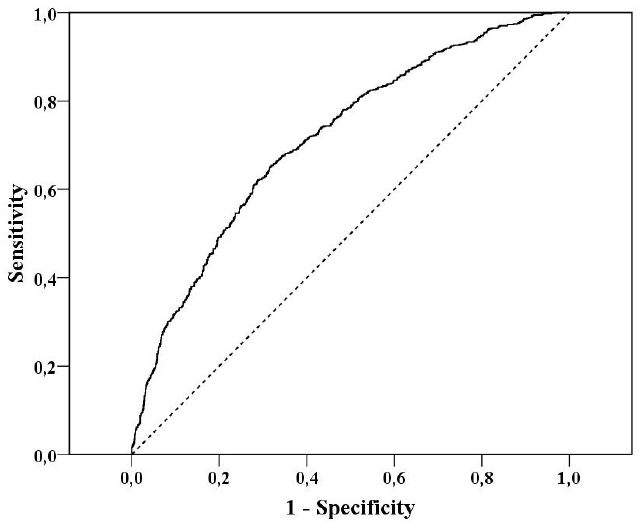
Figure 1. Receiver operating characteristic (ROC) curve examining the discriminatory efficiency of the logistic regression model to detect eating disorder